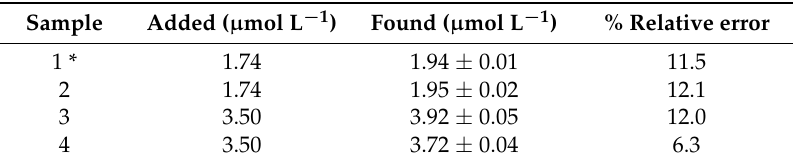
Table 2. Results for RT in urine chemistry control standard.